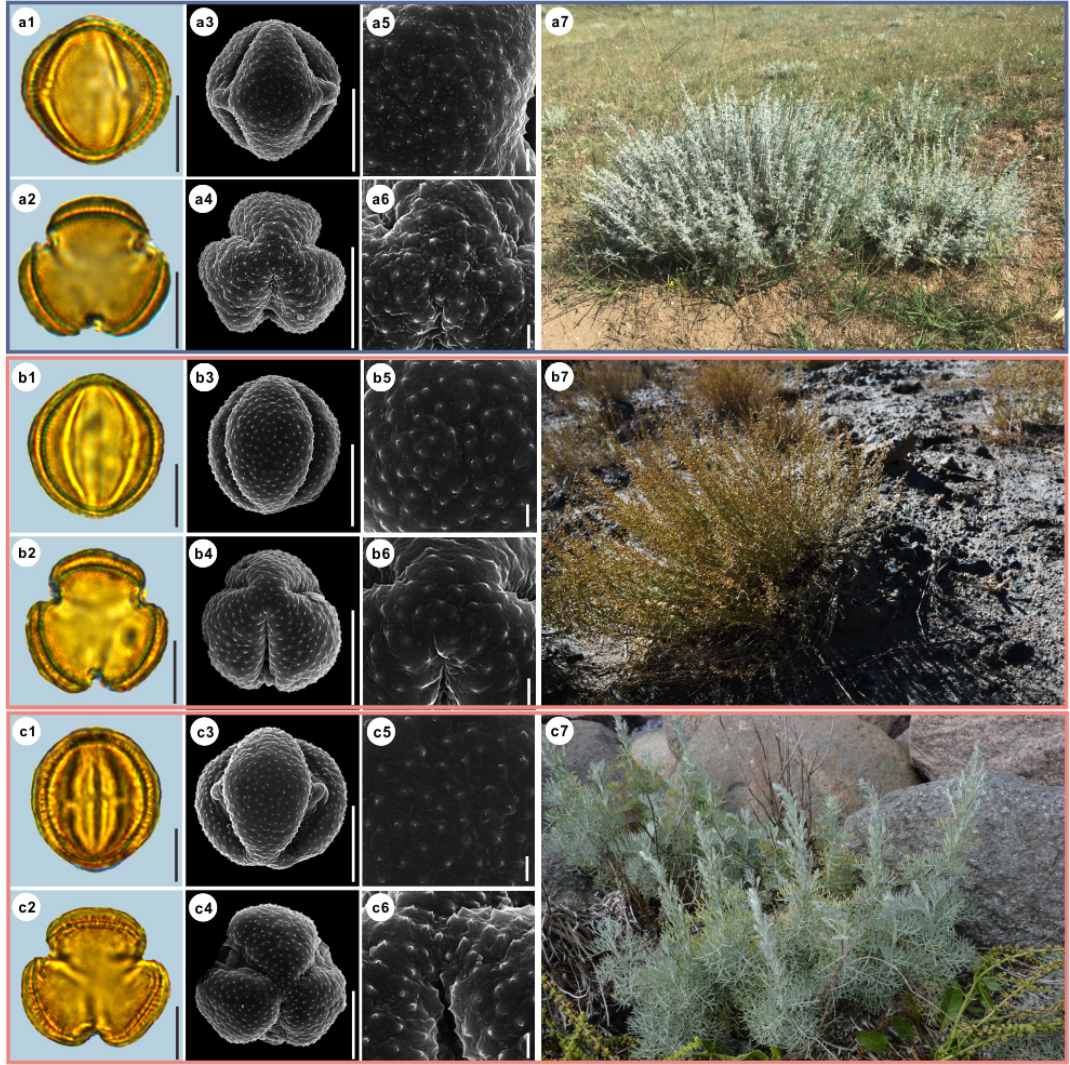
Figure 7. Pollen grains and the habitats of their source plants. (a) Artemisia kurramensis ; (b) Artemisia compactum ; and (c) Artemisia maritima . Pollen grains in equatorial view under LM (a1, b1, c1) and SEM (a3, a5, b3, b5, c3, c5) , in polar view under LM (a2, b2, c2) and SEM (a4, a6, b4, b6, c4, c6) , along with the habitats of their source plants (a7 cited from https://www.inaturalist.org/photos/133758174, last access: 19 August 2022, by © Andrey Vlasenko, b7 provided by © Chen Chen, c7 cited from https://www.inaturalist.org/photos/86515371, last access: 19 August 2022, by © torkild ) . Scale bar in LM and SEM overview 10µm, and in SEM close-up